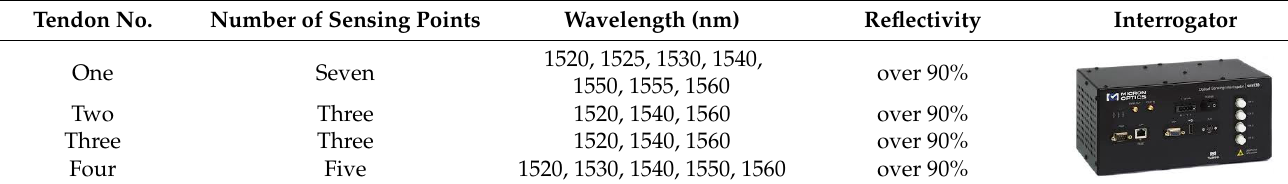
Table 2. Specification of FBG sensor and measurement equipment.